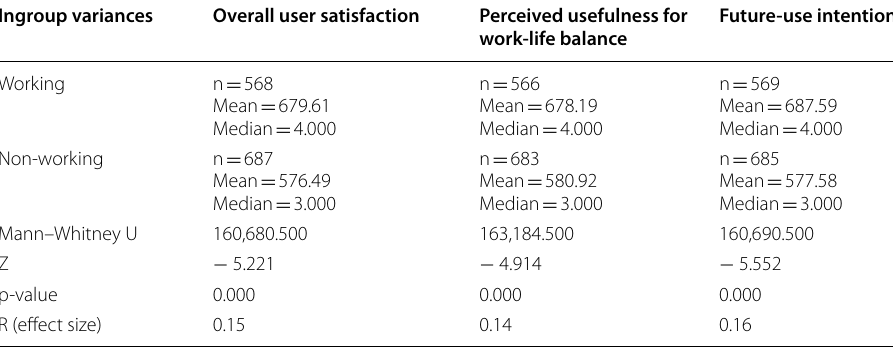
Table 5 Mann–Whitney U test results Ingroup